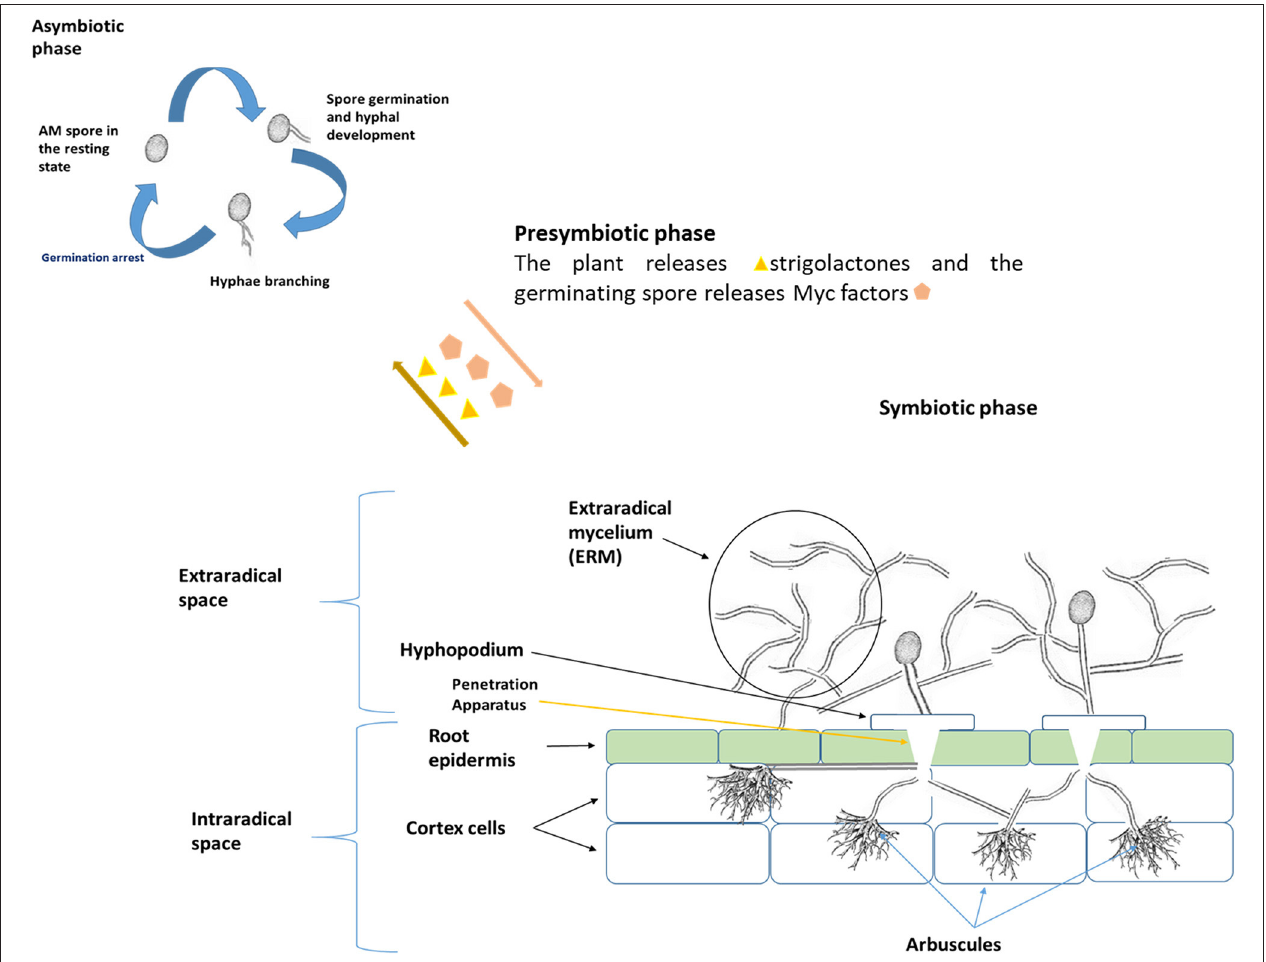
FIGURE 2 | The asymbiotic stage involves spore germination without host associations. The spore utilizes stored reserves of trehalose and lipids to extend its hyphae. In the absence of a host, the hyphae retract, and the spore returns to its resting state. However, when in proximity to a symbiotic host, the spore with extending hyphae moves into the pre-symbiotic stage. In this stage, to encourage further hyphal branching, the plant exudes stigolactones (yellow triangles). In turn, AM fungi release Myc factors (pink pentagons). These chemicals prepare both the plant and AM fungi for association. In the symbiotic phase, the AM fungal hyphae develop a hyphopodium that allows it to rest on the plant root epidermal cells. The development of a PPA in the epidermal cells creates an invagination which guides the growing hyphae past the epidermis into the cortex cells. From the cortex cells, the hyphae branch into tree-like structures called arbuscules. It is through these arbuscules that nutrients are delivered past the periarbuscular membrane where all nutrient transporters are